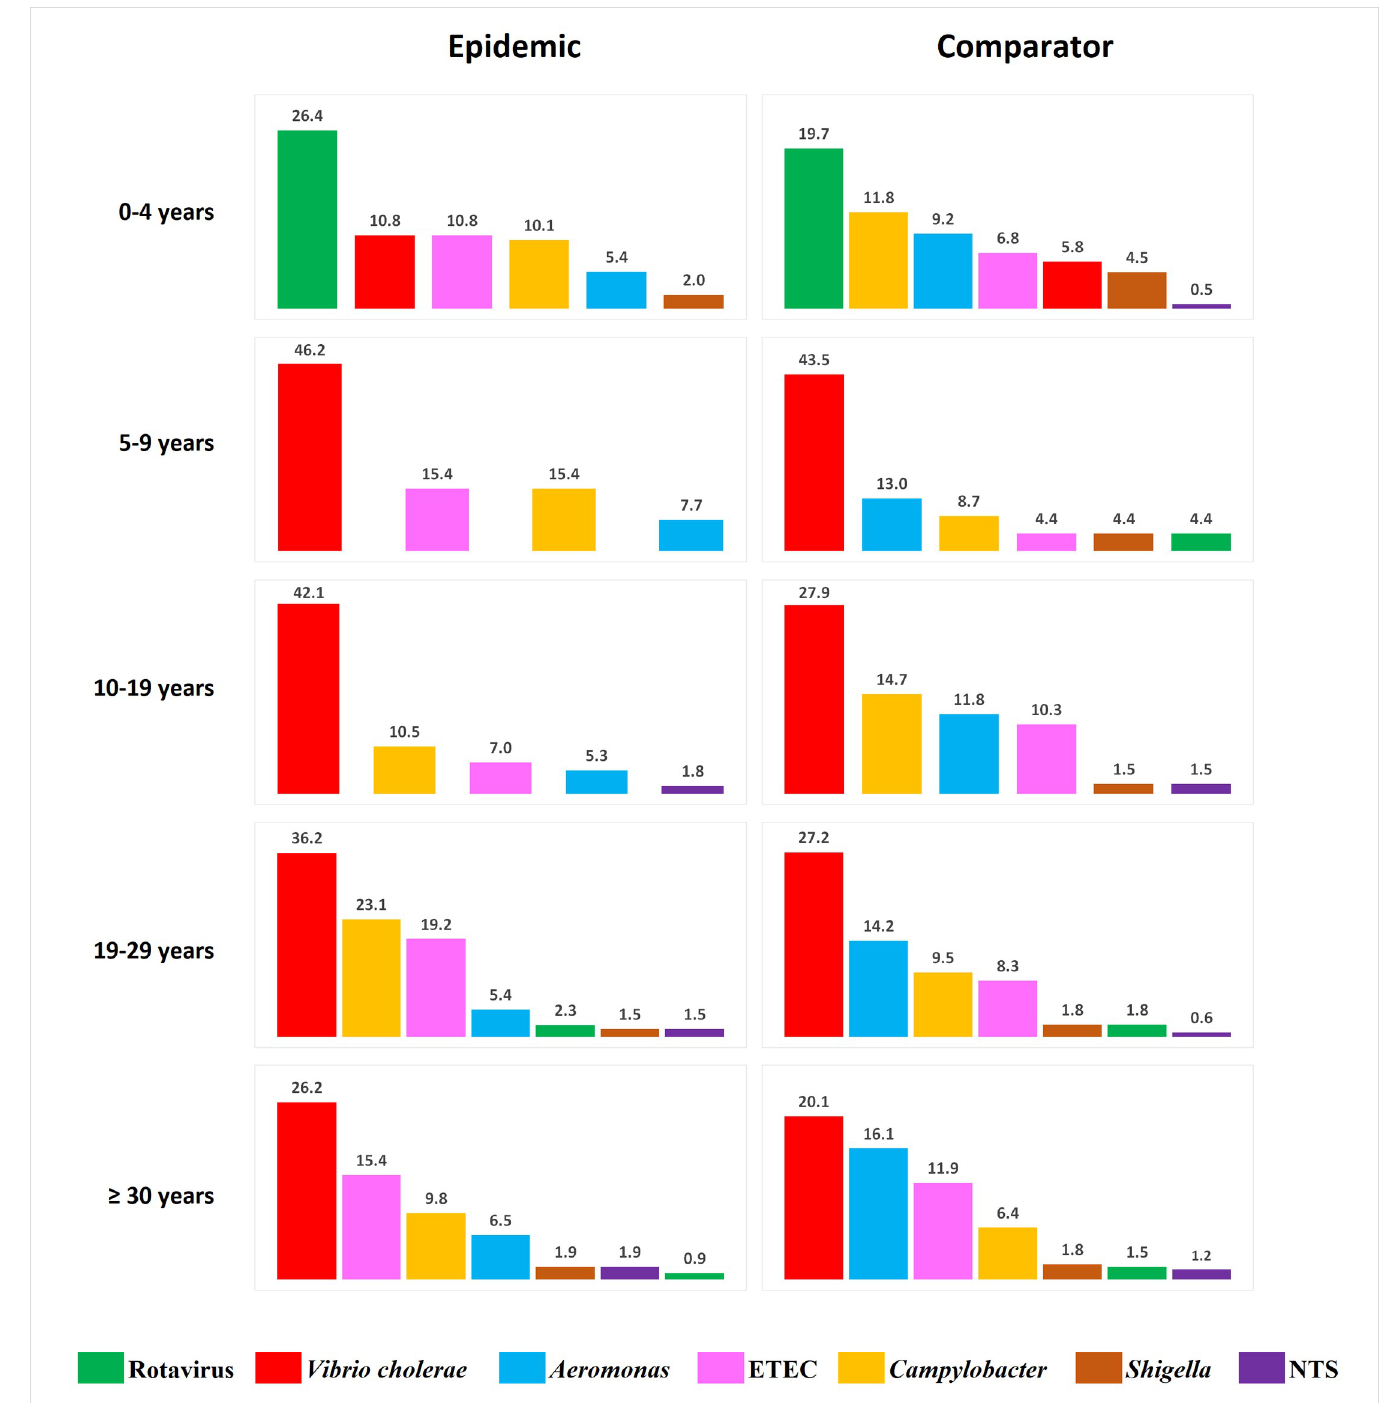
Fig 2. Percent distribution of enteric pathogens isolated from DDSS-enrolled patients treated at icddr,b Dhaka Hospital during the epidemic (cases) and the comparison period (controls) by age groups. The value on top of each column indicates the percentage of samples positive for a particular pathogen. The pathogens (columns) are arranged in decreasing order of prevalence. ETEC, enterotoxigenic Escherichia coli ; NTS, non-typhoidal Salmonella .